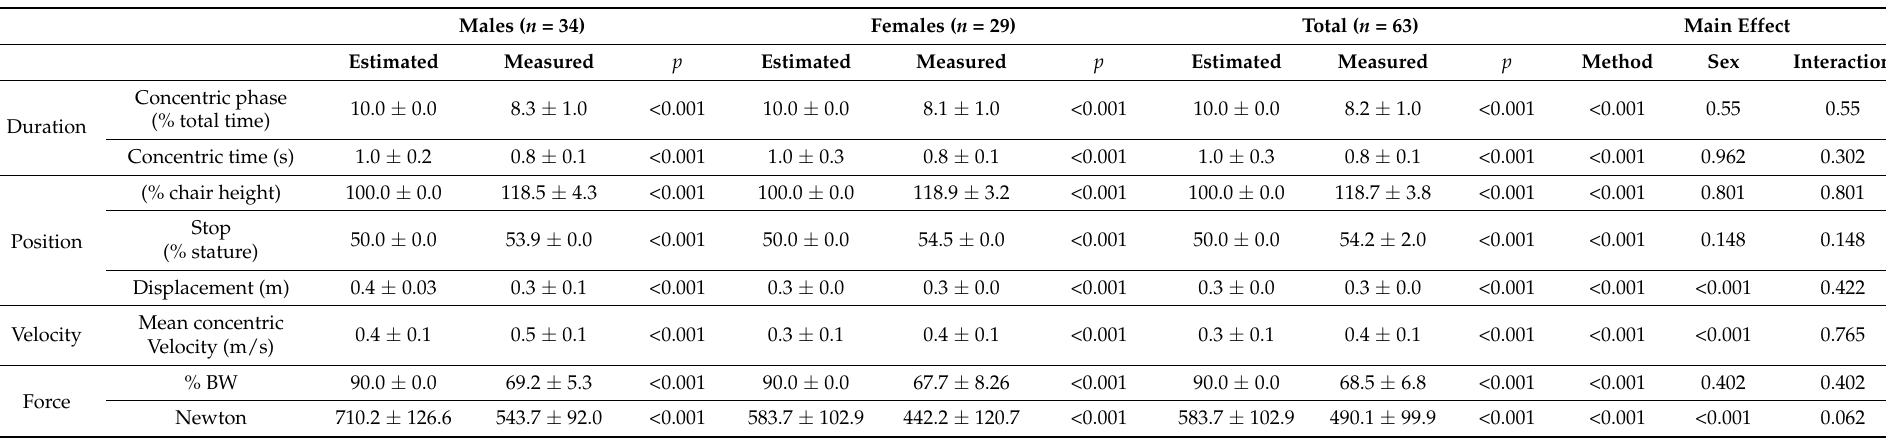
Table 3. Elements of the Alcazar’s calculation of sit-to-stand (STS) mean power. Males ( n = 34) Females ( n = 29) Total ( n = 63) Main Effect Estimated Estimated